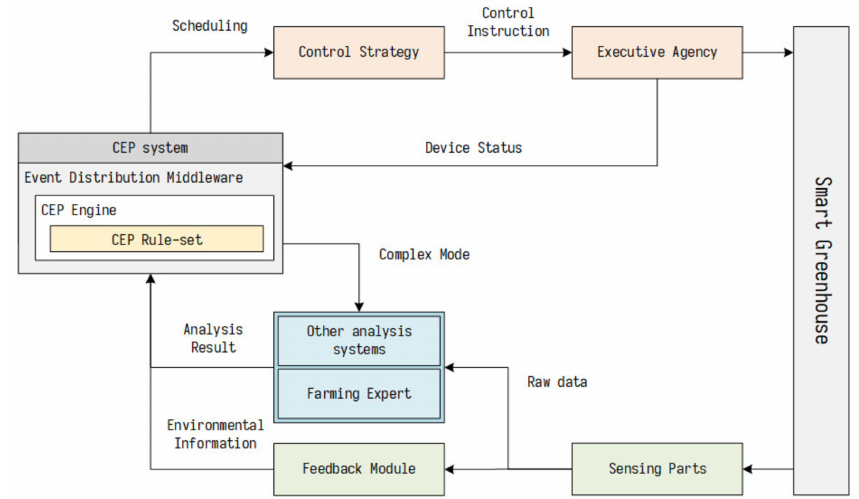
Figure 1. Overall structure of complex event processing